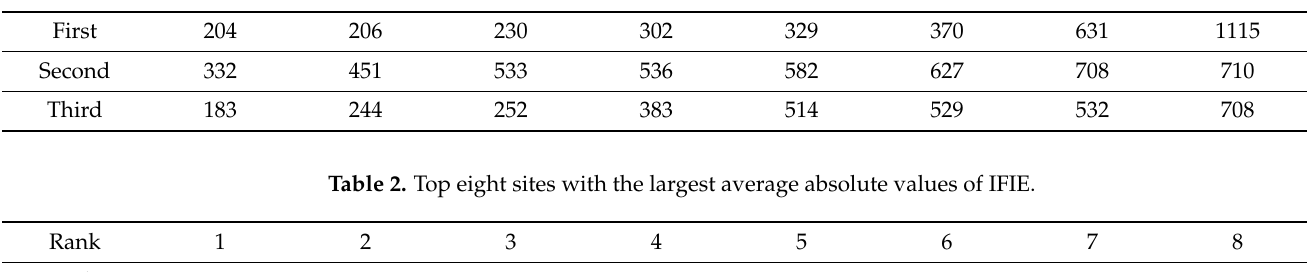
Table 1. Top eight sites with the largest absolute values of eigenvector elements in the first, second, and third left-singular vectors of SVD.